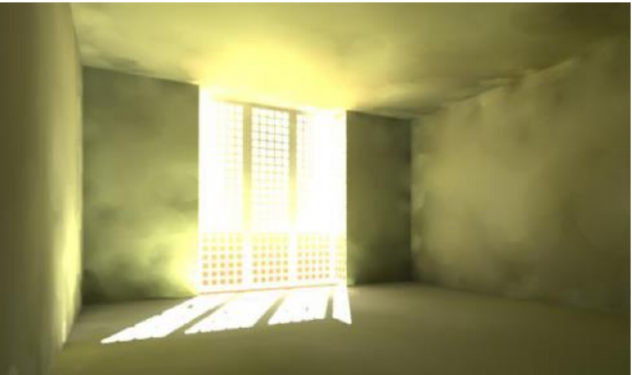
Figure 7. Simulation via Radiance for evaluating lighting level. Reproduced from Batterjee